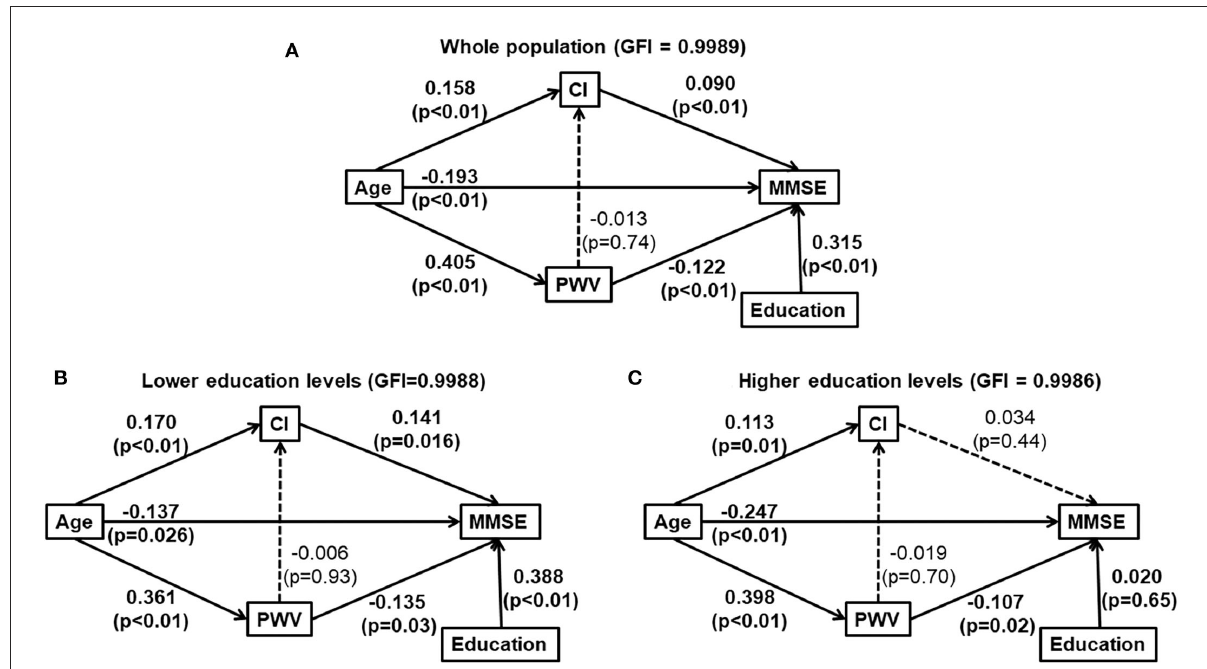
FIGURE2 Path analysis diagrams for the whole study population (A) , subjects with lower education levels [ ≤ 9 years of formal education, (B) ] and those with higher education levels [ > 9 years of formal education, (C) ]. Solid line indicates significant association. Dotted line indicates none-significant association. Path coefficient and its P -value are presented for the evaluation of direct effect between two adjacent variables. (A) was for whole population and (B,C) were for those elders with and without lower education, respectively. CI, cardiac index; education, years of formal education; GFI, the goodness of fitness index; MMSE, Mini-Mental State Examination; PWV, carotid-femoral pulse wave velocity; The interrelationship of cardiac index (CI), carotid-formal pulse wave velocity (PWV), education and cognitive function (Mini-Mental State